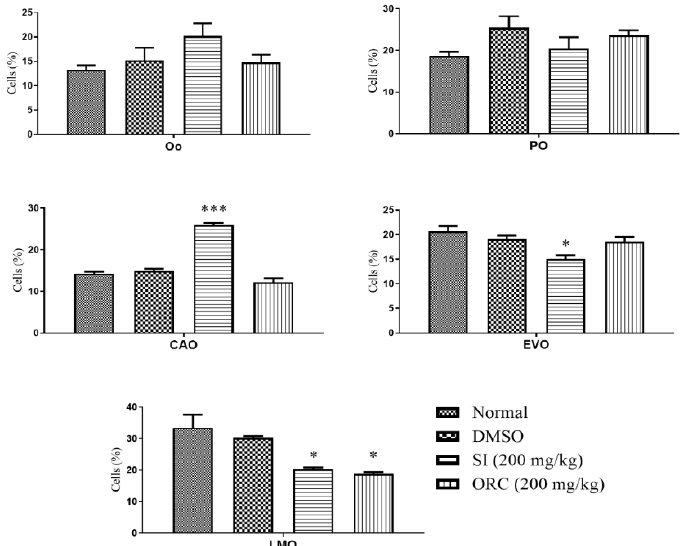
Figure 5. Effect of oral treatment with Ormona ® SI (OSI) and Ormona ® RC (ORC) (200 mg/kg) on frequency of females’ follicle stage (mean ± SD). ***: p < 0.001, *: p < 0.05, one-way ANOVA followed by the post hoc Tukey test. Oogonium (Oo), perinucleolar oocyte (PO), cortical alveolar oocyte (CAO), early vitellogenic oocyte (EVO), late mature oocytes (LMO).